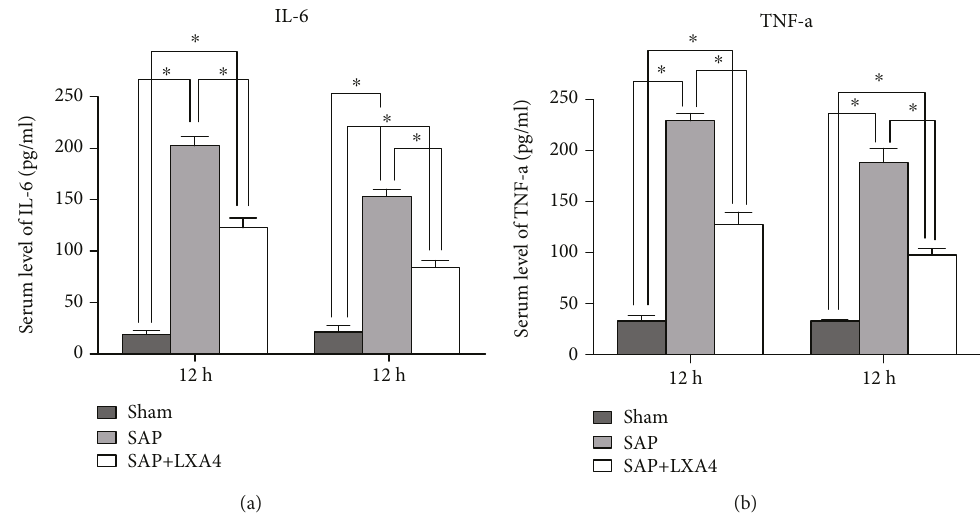
Figure 8: Downregulated levels of proin fl ammatory cytokines in SAP by AT-Lipoxin A4 administration. (a) Serum IL-6 was increased signi fi cantly in the SAP group compared with the sham group. AT-Lipoxin A4 treatment signi fi cantly reduced the levels of serum IL-6. (b) Serum TNF- α was increased signi fi cantly in the SAP group. AT-Lipoxin A4 treatment signi fi cantly reduced the levels of serum TNF- α . ∗ P < 0 05